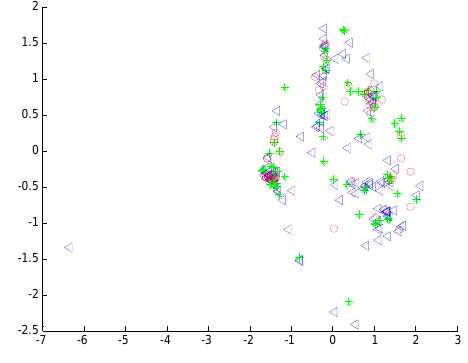
Fig. 2 Two-dimensional ISOMAP embedding of tourist